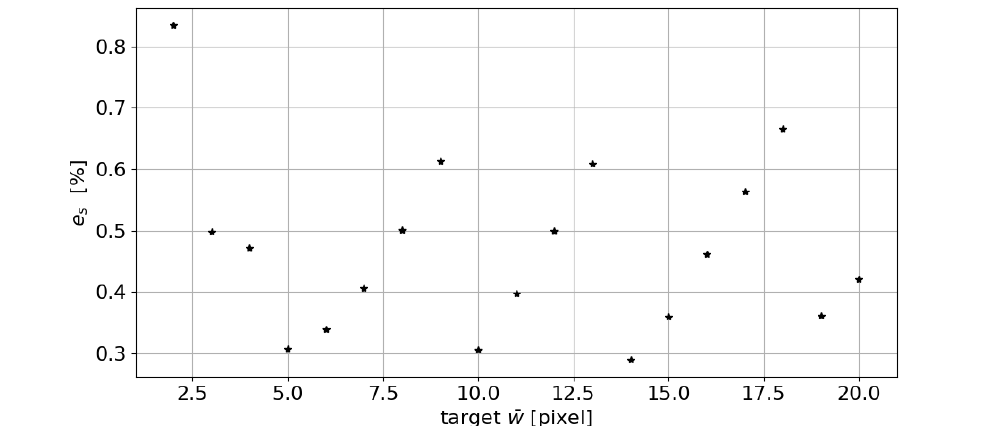
Figure 7. Absolute percentage error e s trend in the measurement of the line mean width as the target ¯ w